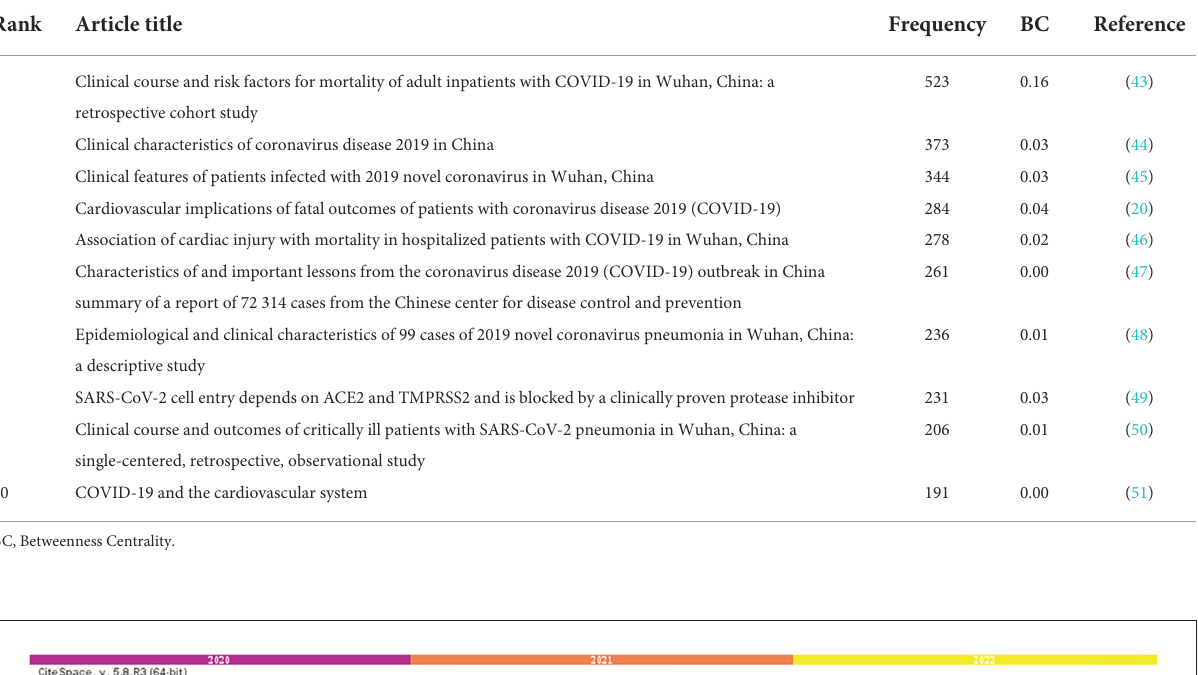
TABLE 5 Top 10 most cited references of publications in CVDs and COVID-19 research.